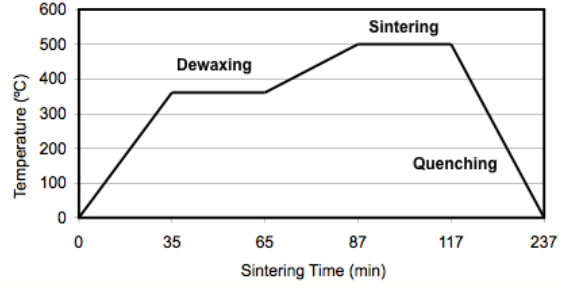
Figure 1. Sintering schematic of uni-axial die compaction